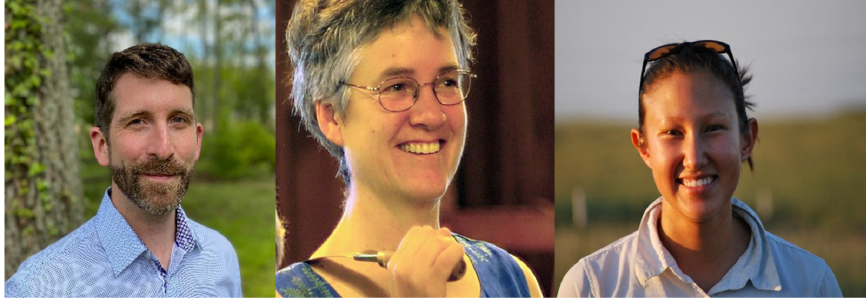
Figure 1. Benton N. Taylor, Ellen L. Simms and Kimberly J. Komatsu (from left to right).